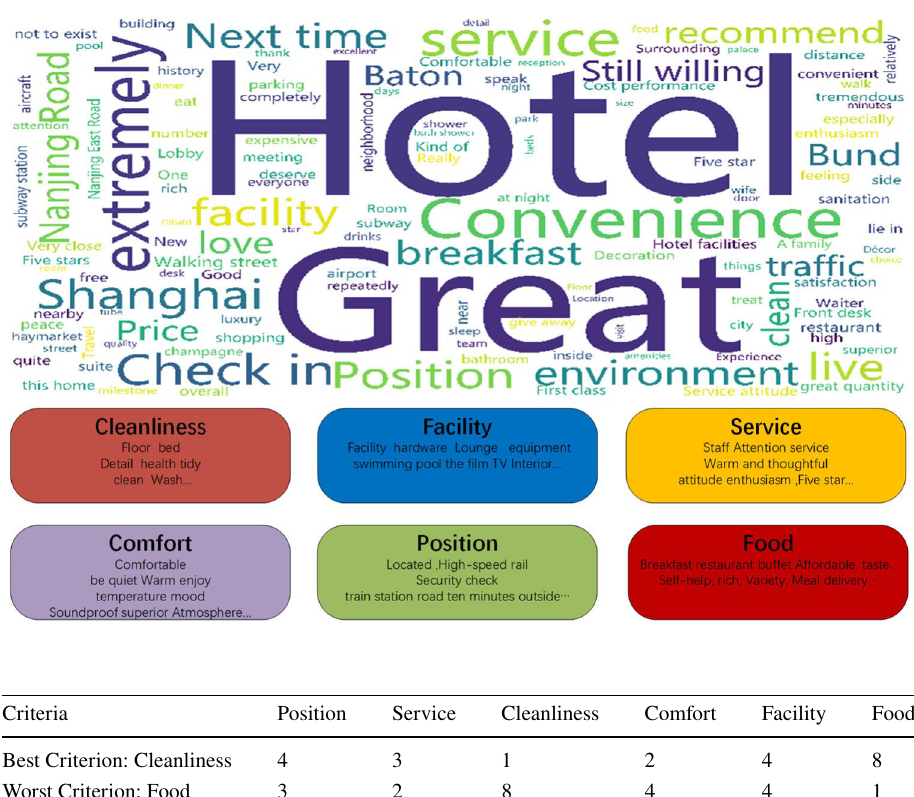
Fig. 4 Classification results for sub-criteria